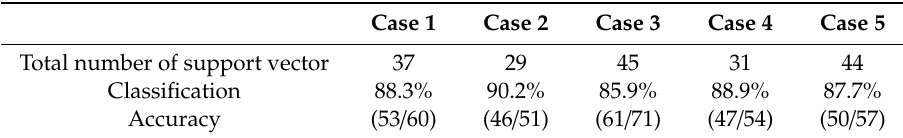
Figure 4. Schematic diagram of cross-validation grouping. Table 7. Results of SVM classification.